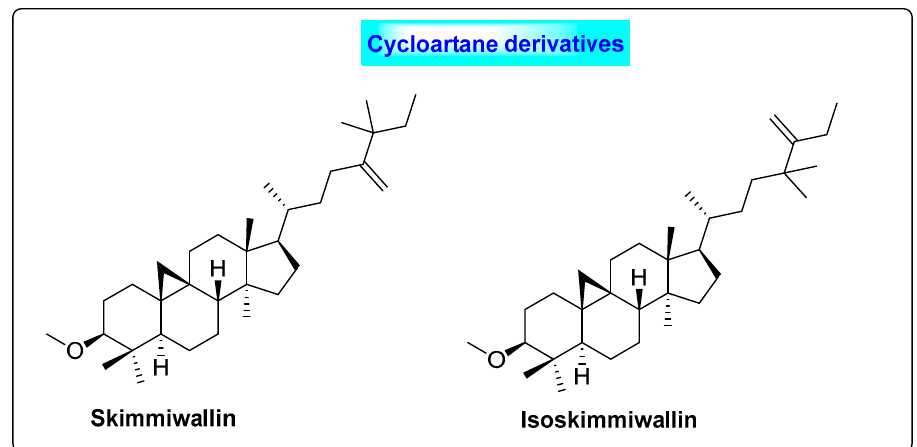
Figure 9. Triterpenoids of Cocos nucifera that possess anti-androgenic activity.